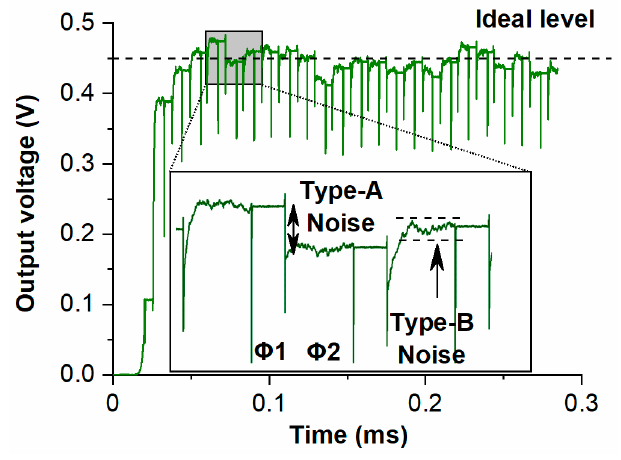
Figure 3. The typical transient output noise waveform of CVC.